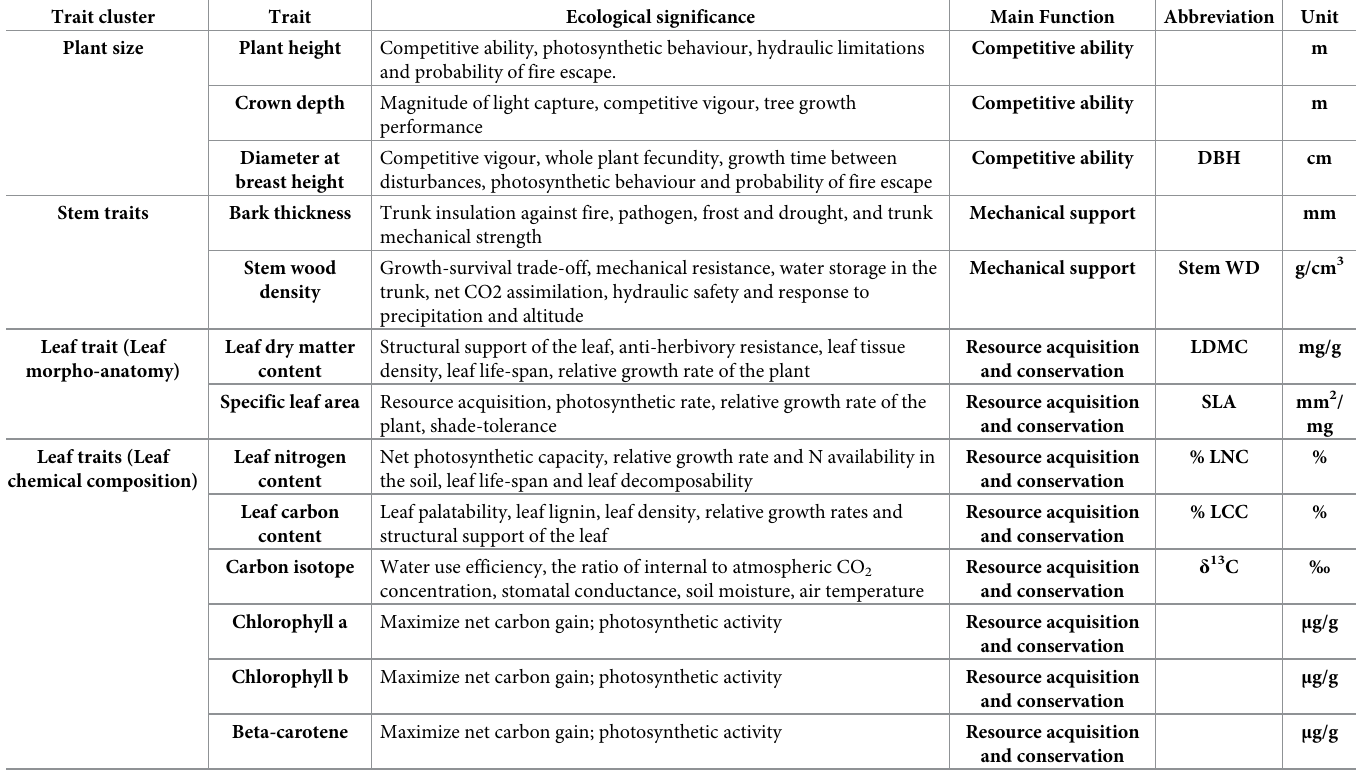
Table 1. Study traits and their functional significance. Trait cluster